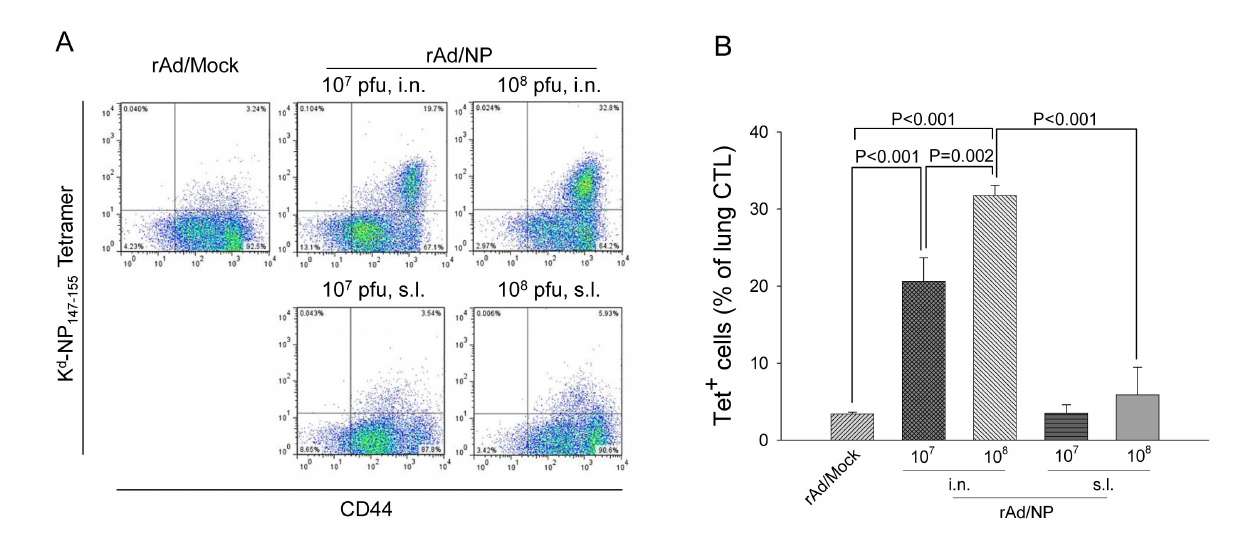
Figure 3. Analysis of influenza virus NP-specific CD8 T-cell responses in the lungs of rAd/NP-immune mice. BALB/c mice were immunized intranasally or sublingually with 1×10 7 PFU or 1×10 8 PFU of rAd/NP. Control mice were immunized intranasally with rAd/Mock. Mice that received rAd/NP via sublingual route were boosted two weeks after the primary vaccination. Subsequently mice in all vaccination groups were challenged intranasally with 10 LD of PR8 virus three weeks after their last immunization. (A) 50 At day 5 post-challenge, lung cells were harvested from mice (n = 5) in each group and stained with K d /NP tetramer, anti-CD8, 147-155 and anti-CD44 antibody. The percentage of K d /NP tetramer-positive, CD44-positive cells among total lung CD8-positive cell 147-155 population was indicated in the upper right quadrant. (B) The average percentages of K d /NP tetramer-specific CD8 T cells in 147-155 the lungs of five mice per